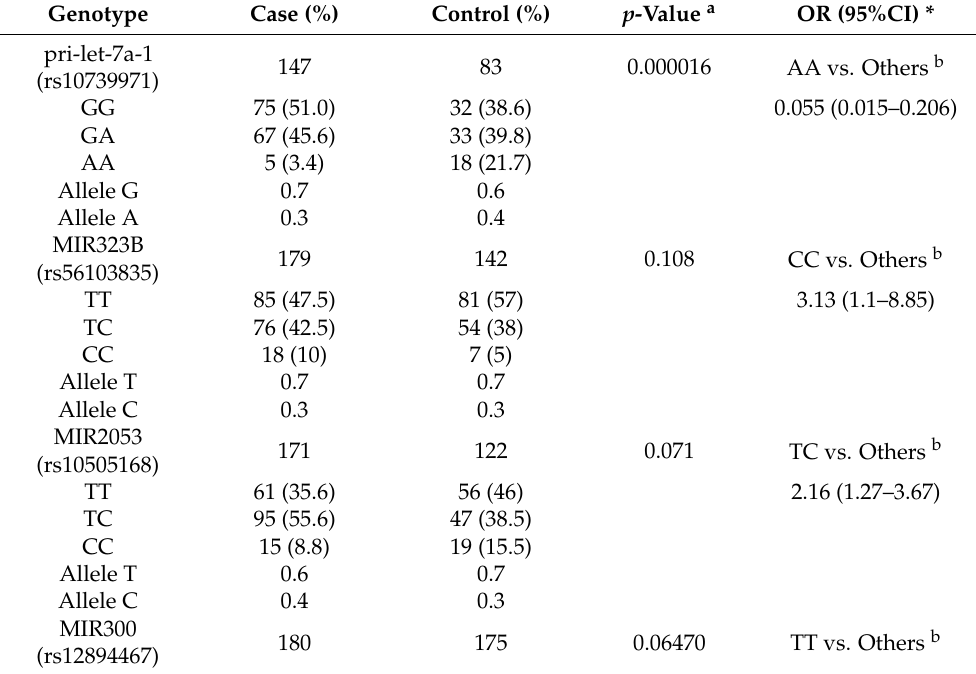
Table 2. Distribution of the alleles and genotypes of the polymorphisms investigated in the present study in patients with gastric cancer in comparison with the control